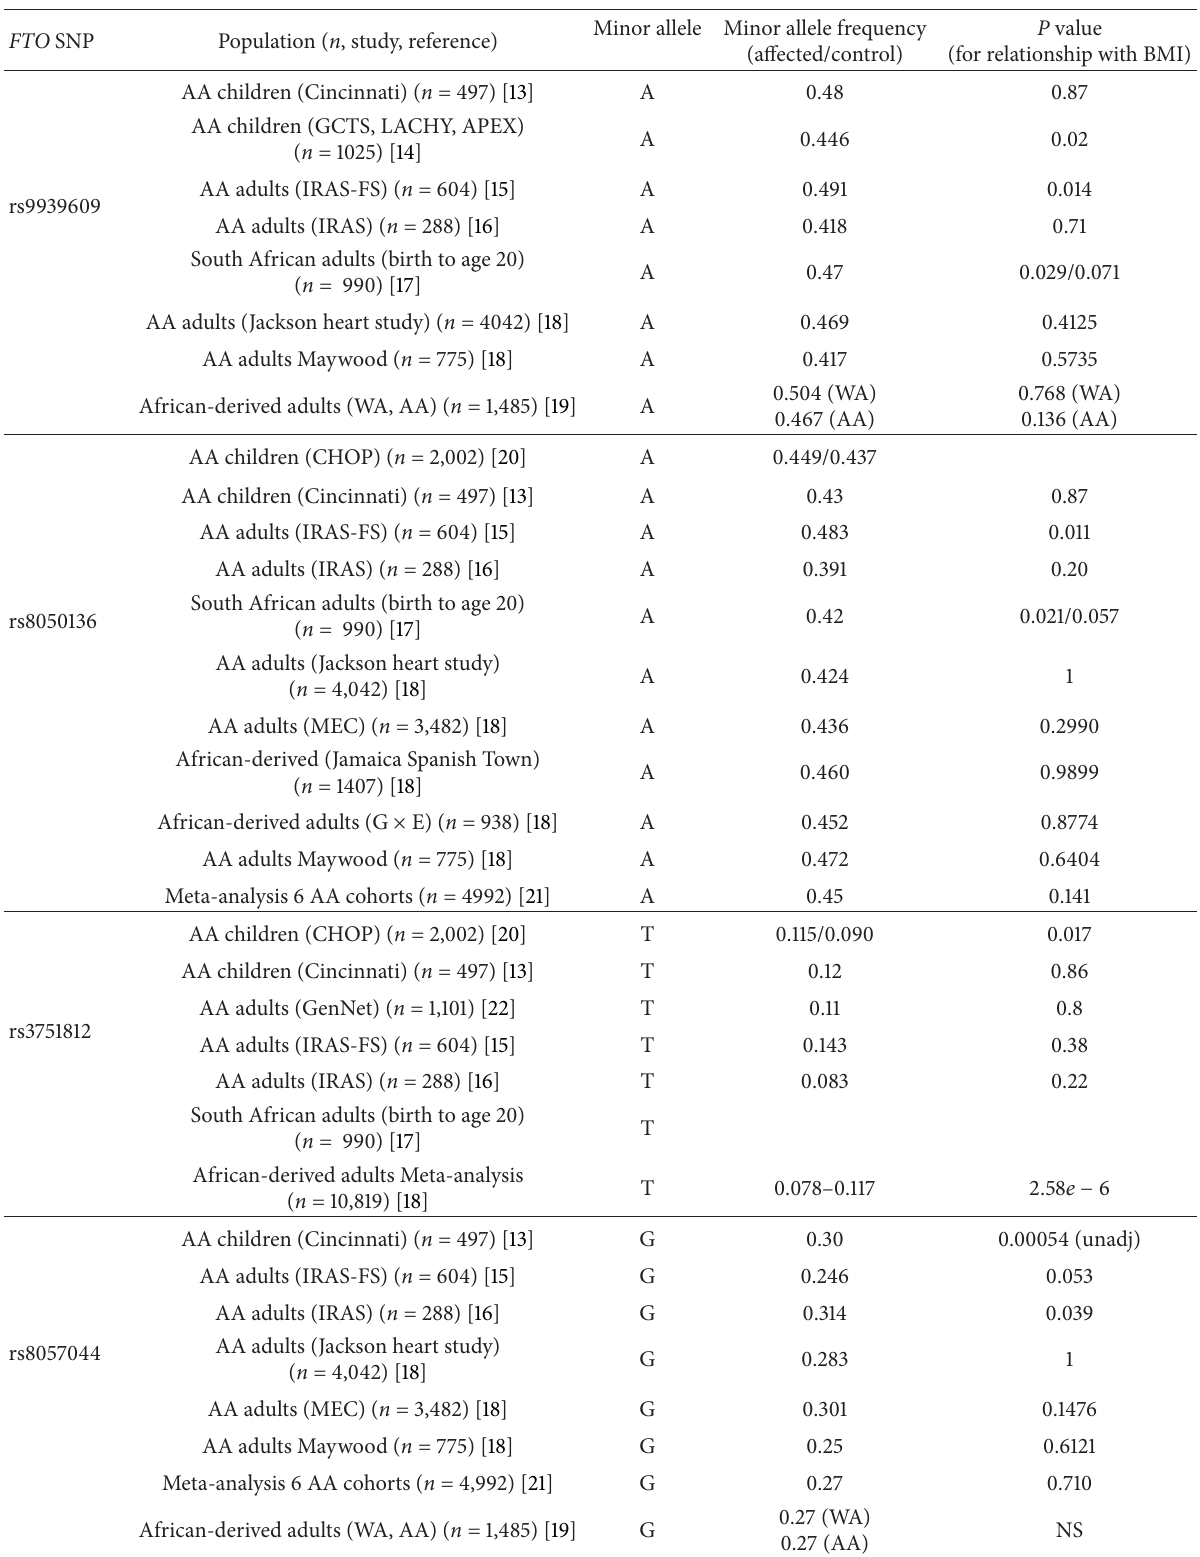
Table 1: (a) FTO variation and BMI in populations of African ancestry and (b) degree of linkage disequilibrium between FTO SNPs in Table 1(a) in the YRI population